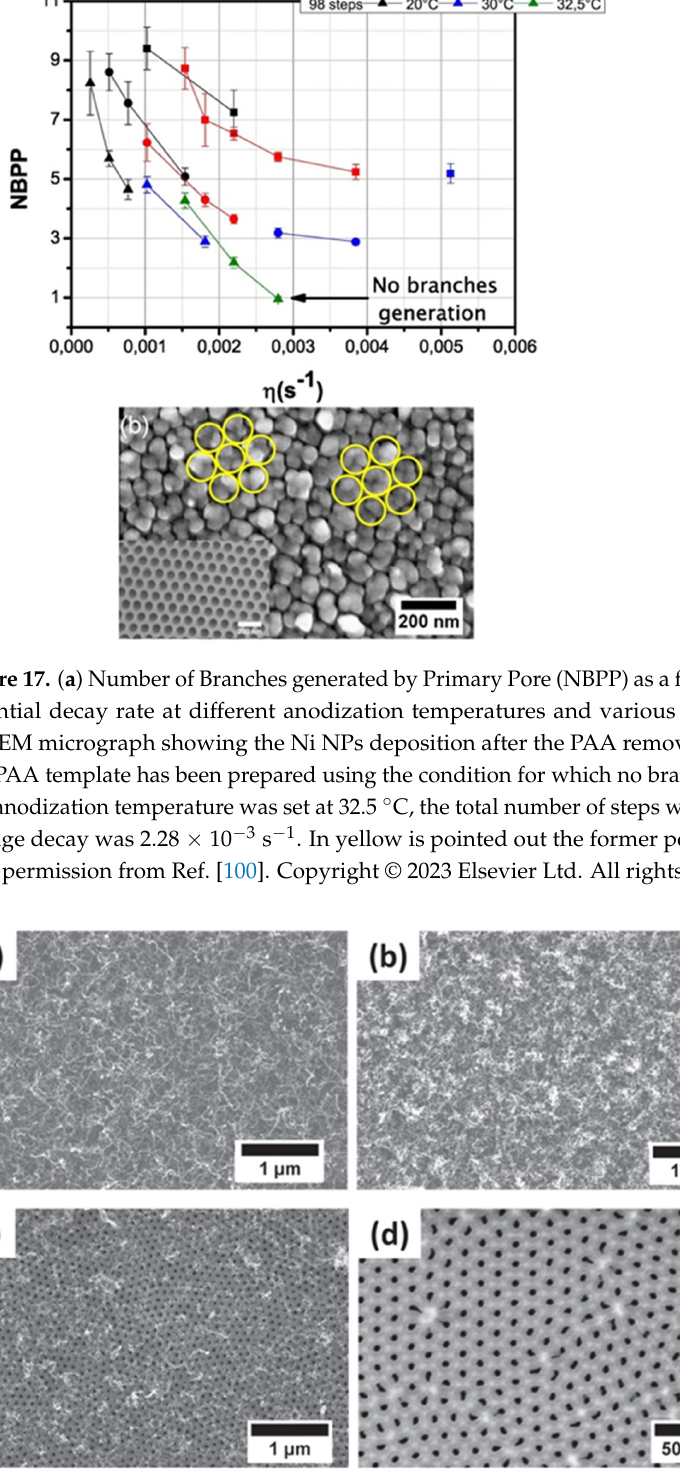
Figure 18. SEM micrographs of PAA templates fabricated with different Number of Branches generated by Primary Pore (NBPP) and subsequently Ni electrodeposition and CNTs synthesis. ( a ) 2, ( b ) 3, ( c ) 6 and ( d ) 7 NBPP. Same CNT synthesis conditions were applied for all of the PAA/Ni composites. Reprinted with permission from Ref. [83]. IOP Science Copyright © 2023.